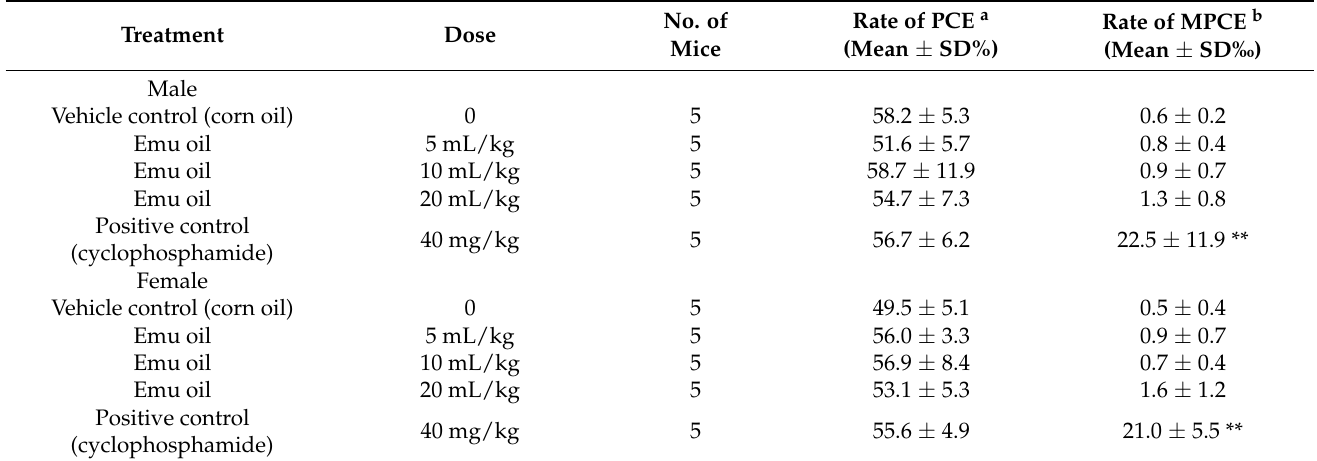
Table 5. Summary results of micronucleus test conducted on emu oil.